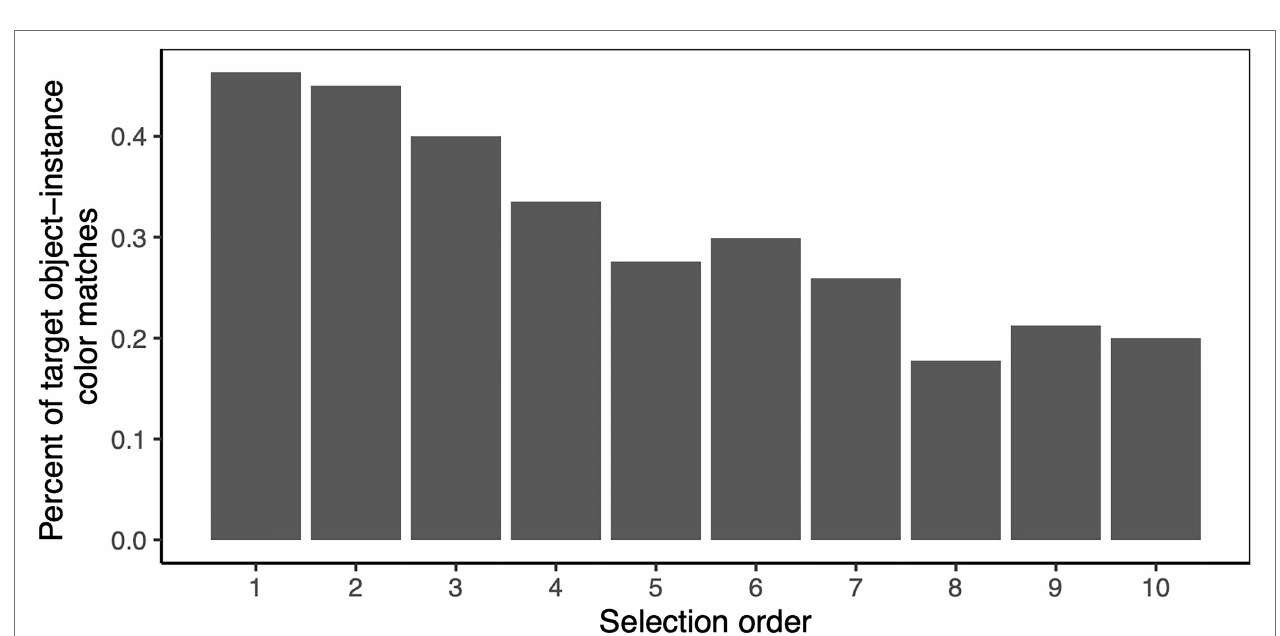
FIGURE 8 | Percent of search template-instance color matches by selection